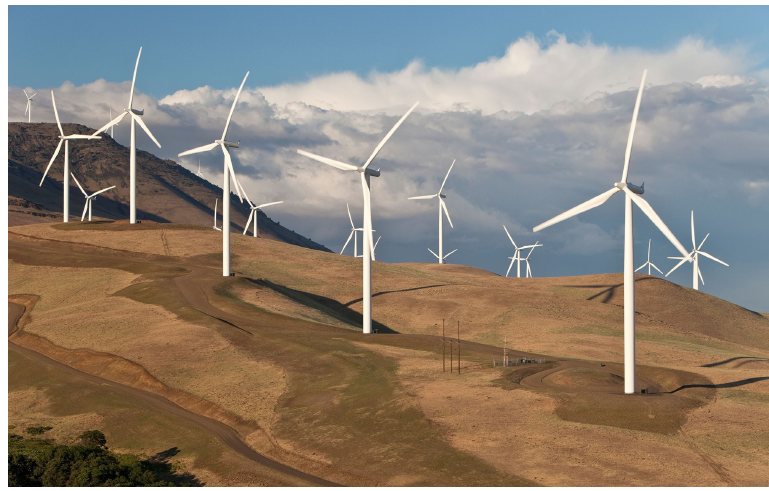
Figure 1. Wind Farm [32]. Photograph by INGA SPENCE/ALAMY STOCK